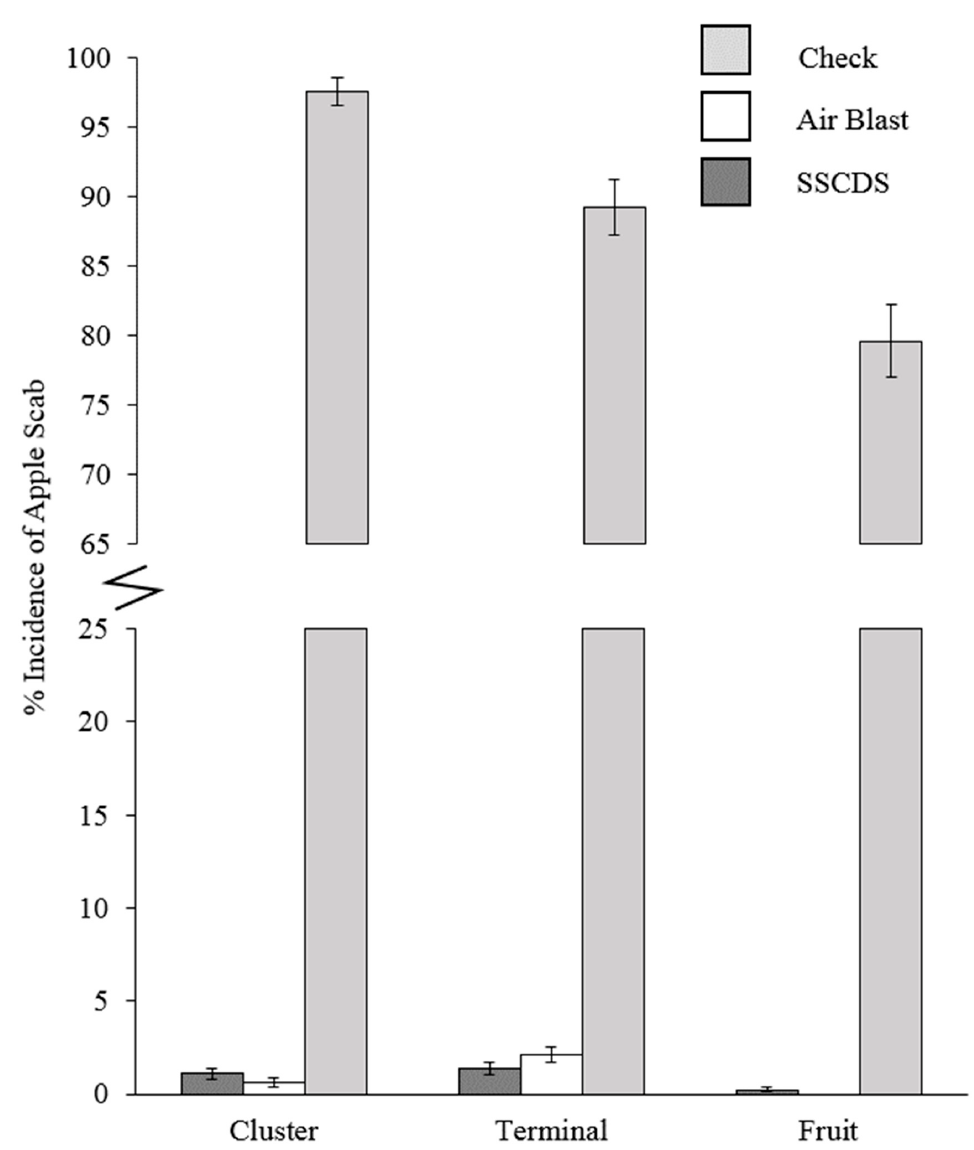
Figure 7. Observed percent incidence of apple scab in each tissue type. Mean incidence shown from the airblast and SSCDS treated plots, with a comparison check from a nearby untreated orchard (Check not included in statistical analysis). Error bars indicate standard error of the proportion.